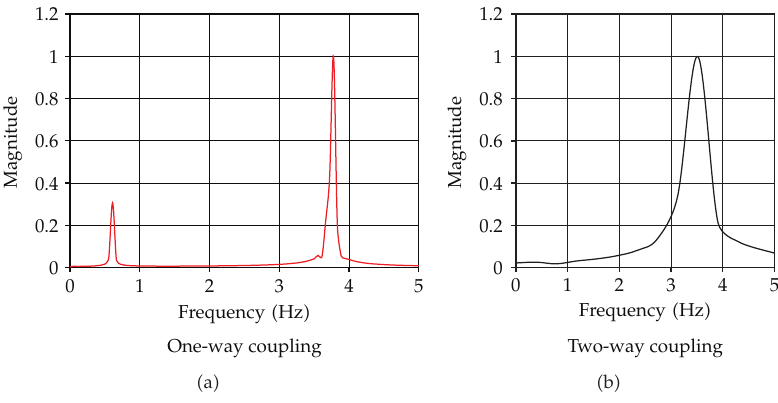
Figure 12: Frequency spectrum, v (cid:8) 0 . 34m/s, plate